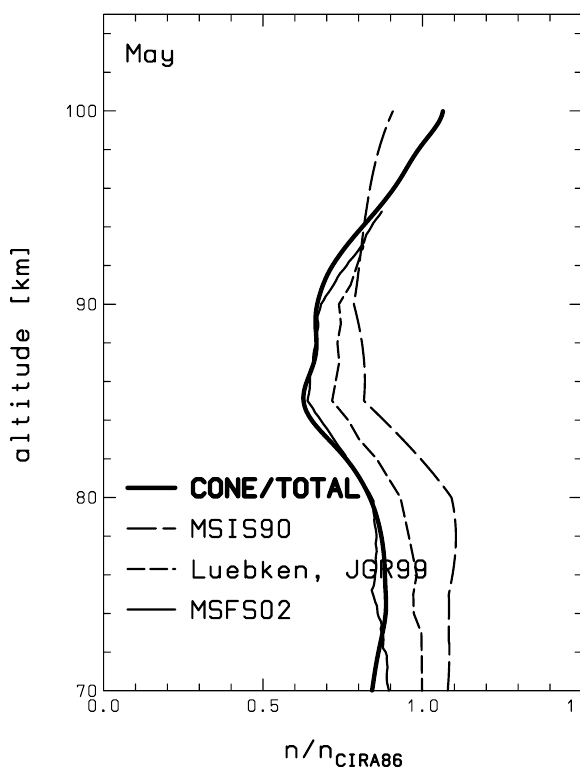
Fig. 11. As for Fig. 9 but for the months January through March. The falling sphere densities have been adopted from L¨ubken and von Zahn (1991).